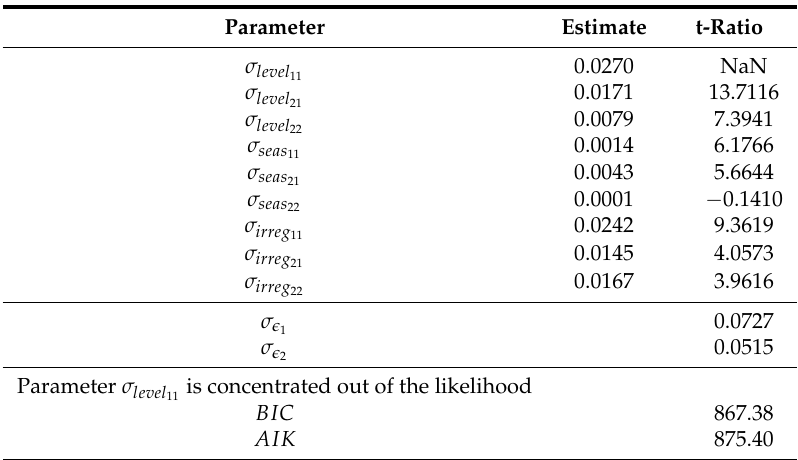
Table A17. Endogenous variables: log IPI extraction of crude petroleum and natural gas log production of natural gas.